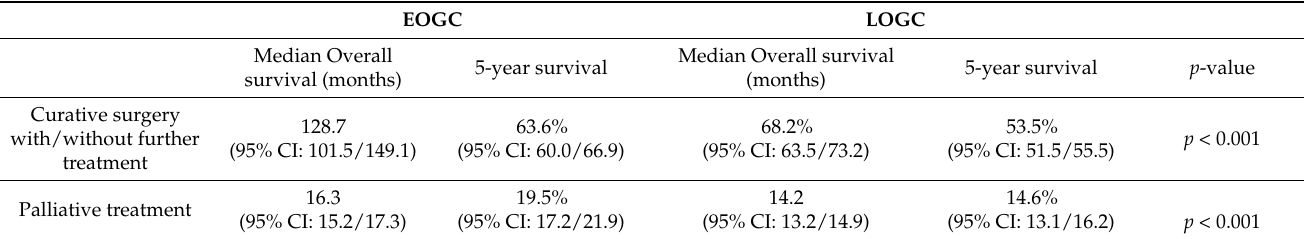
Table 2. Median overall survival and five-year survival for curative surgery with/without further treatment and palliative treatment in EOGC and LOGC.